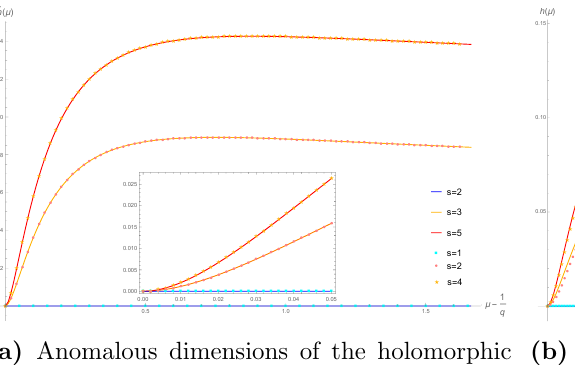
Anomalous dimensions of the anti- holomorphic higher-spin operators. Here we plot the right dimension h of the operators and the left dimension is ~ h = h + s . (cid:16) (cid:17) + 1 . The solid curves denotes oper- q